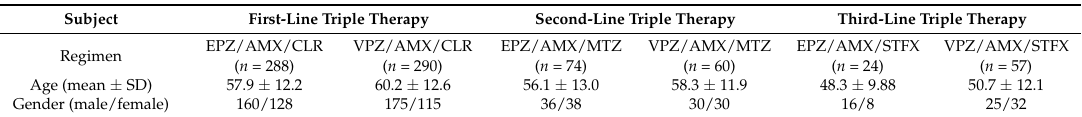
Information of patients who received Helicobacter pylori eradication therapy.